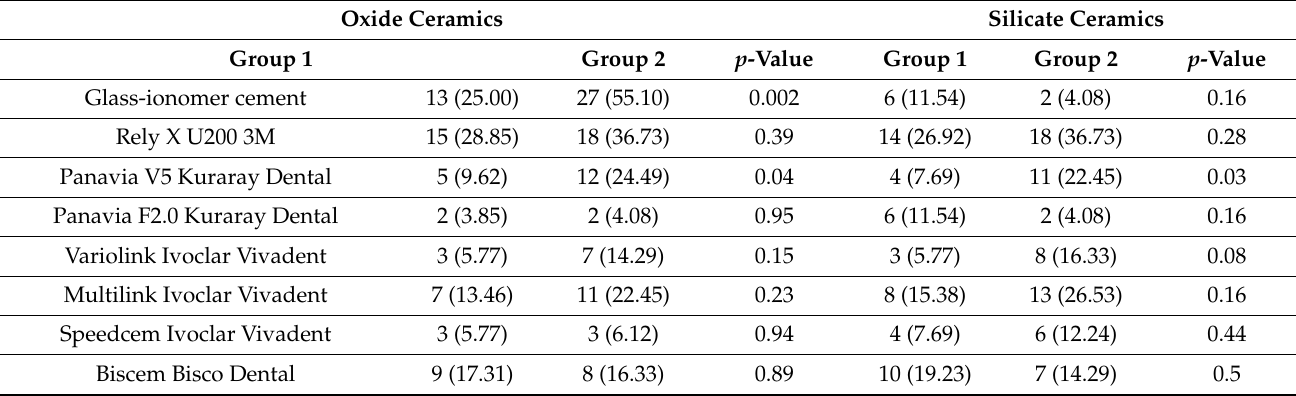
Table 2. Types of cement used for ceramic